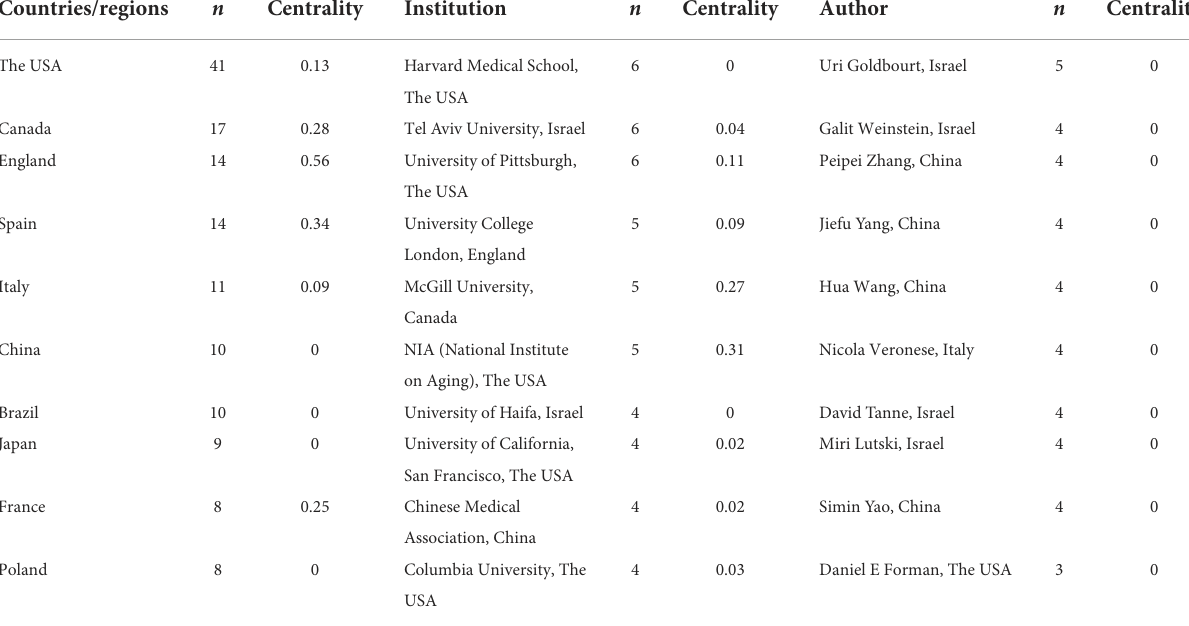
TABLE 1 Top ten countries/regions, institutions and authors according to the frequency of articles related to CVD with frailty. Countries/regions